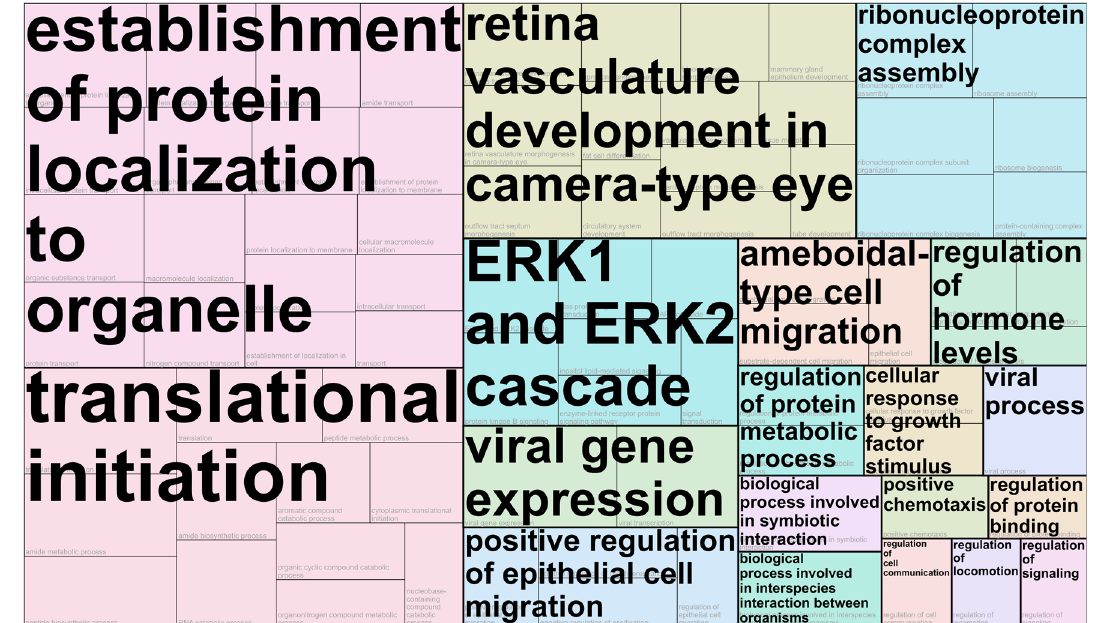
Fig. 5 Tree map summarizing over‑represented Gene Ontology terms for genes that were only classified as hyper‑variable (n long‑term survivors of childhood‑cancer with at least one second primary neoplasm in reaction to exposure to 0.05